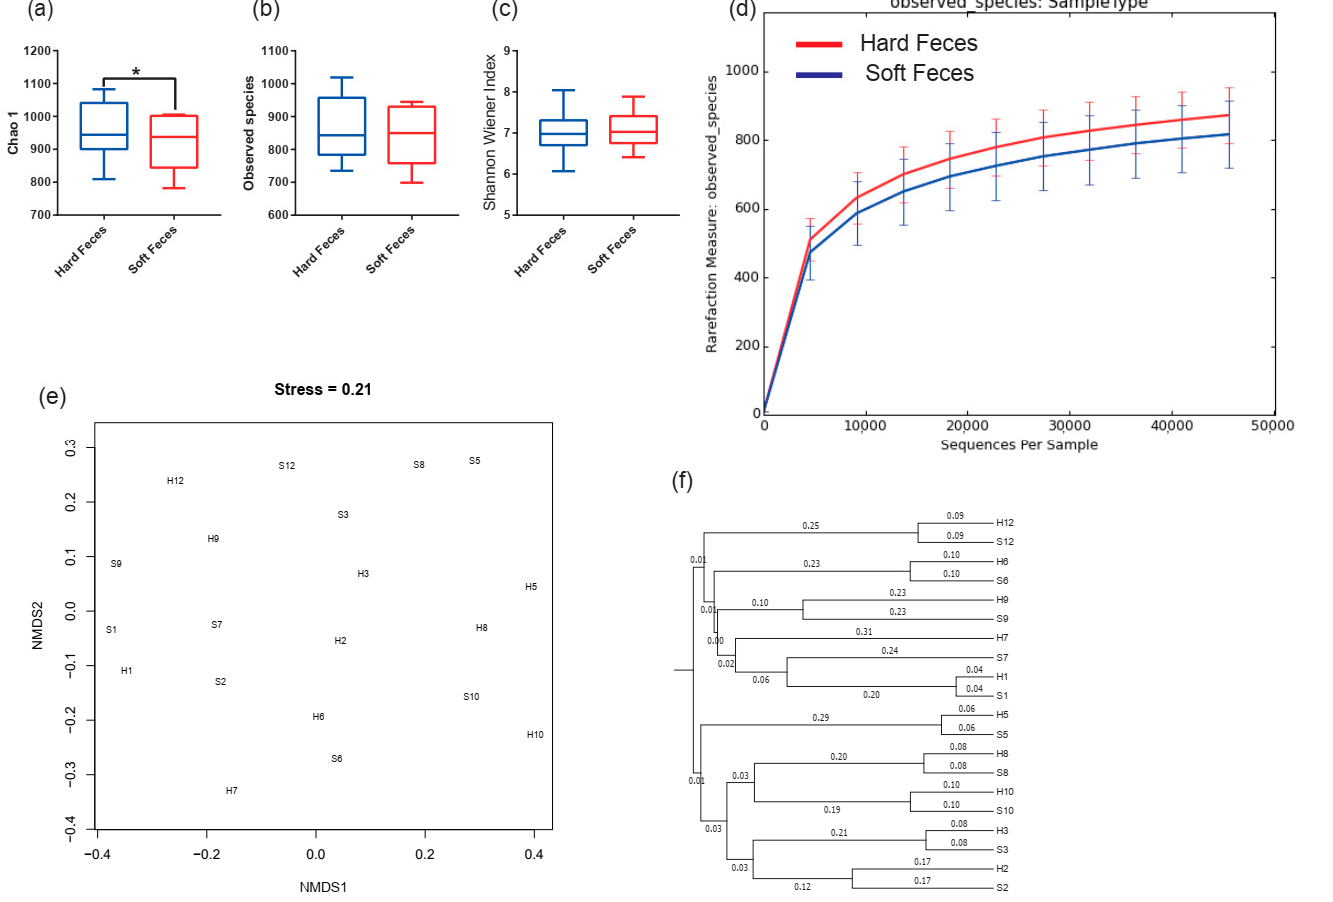
Figure 3. Alpha and beta diversity across all samples; asterisks indicate the levels of statistical significance between groups (Wilcoxon rank-sum test: * p < 0.05). ( a ) The Chao1 diversity index. ( b ) The observed species diversity index. ( c ) The Shannon–Wiener index. ( d ) Rarefaction curve. ( e ) Nonmetric multidimensional scaling (NMDS) based on Bray–Curtis distance. ( f ) Bray–Curtis dissimilarities cluster.